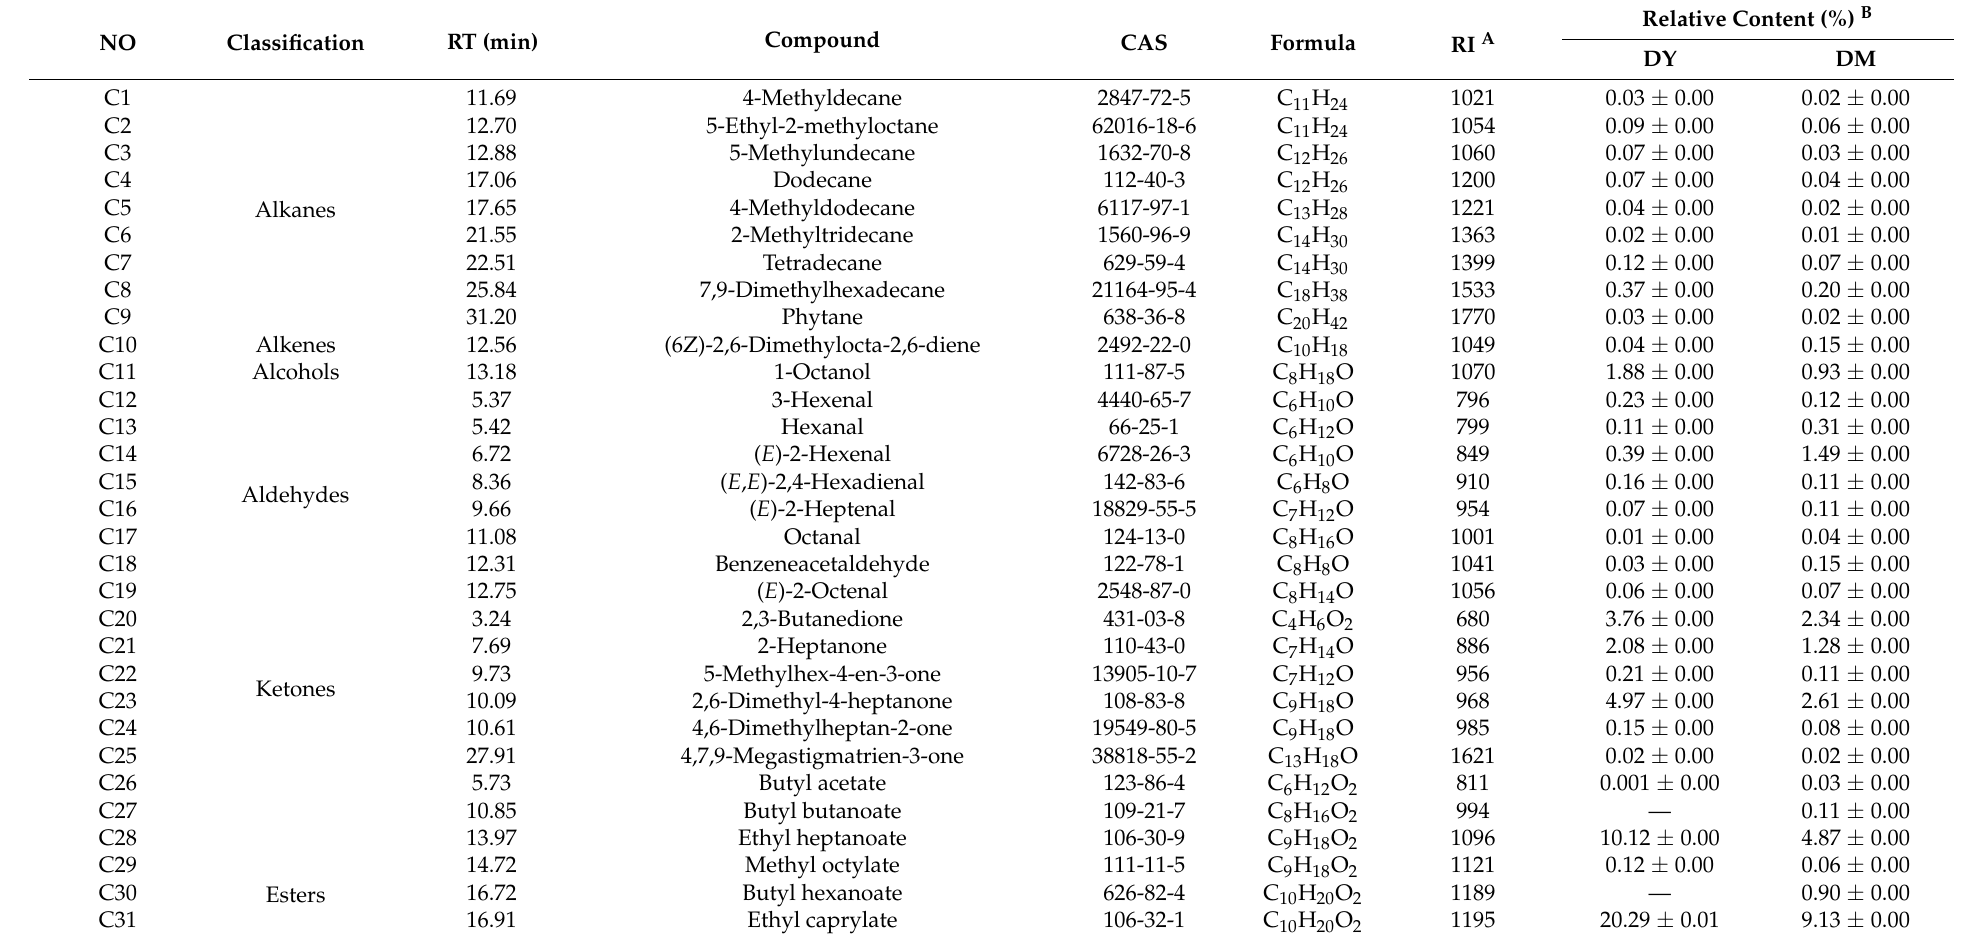
Table 1. Volatile compounds and their relative contents in D. delavayi fruit of varying